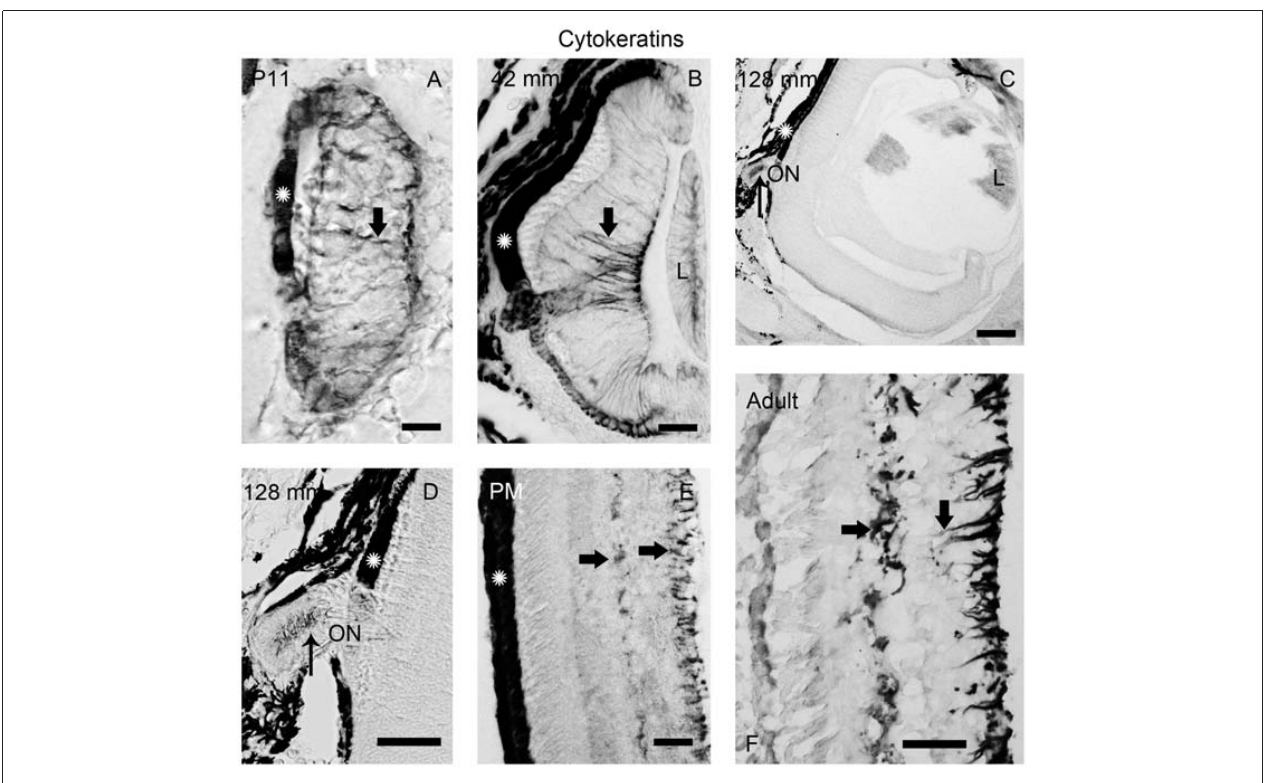
FIGURE 5 | Photomicrographs of transverse sections of the retina showing anti-cytokeratin immunoreactivity. (A) Prolarval retina. (B) Retina of a small larva. (C,D) Retina of a premetamorphic larva (C) and detail of the ON (D). (E,F) Retina of postmetamorphic (E) and upstream migrating adult (F) sea lampreys. Cytokeratin-ir Müller cells (thick arrows) were observed in the prolarval (A) , small larval (B) and postmetamorphic/adult (E,F) retinas. Note the lack of cytokeratin labeling in the premetamorphic retina (C) , although the ON shows cytokeratin-ir astrocytes (thin arrows in D ). In postmetamorphic/adult sea lampreys (E,F) only the inner processes of the Müller cells show anti-cytokeratin immunoreactivity. In all photomicrographs dorsal is up and medial is to the left. Scale bars: 12.5 µ m in (E) ; 25 µ m in (A,B,D) ; 50 µ m in (F) ; 100 µ m in (C) .